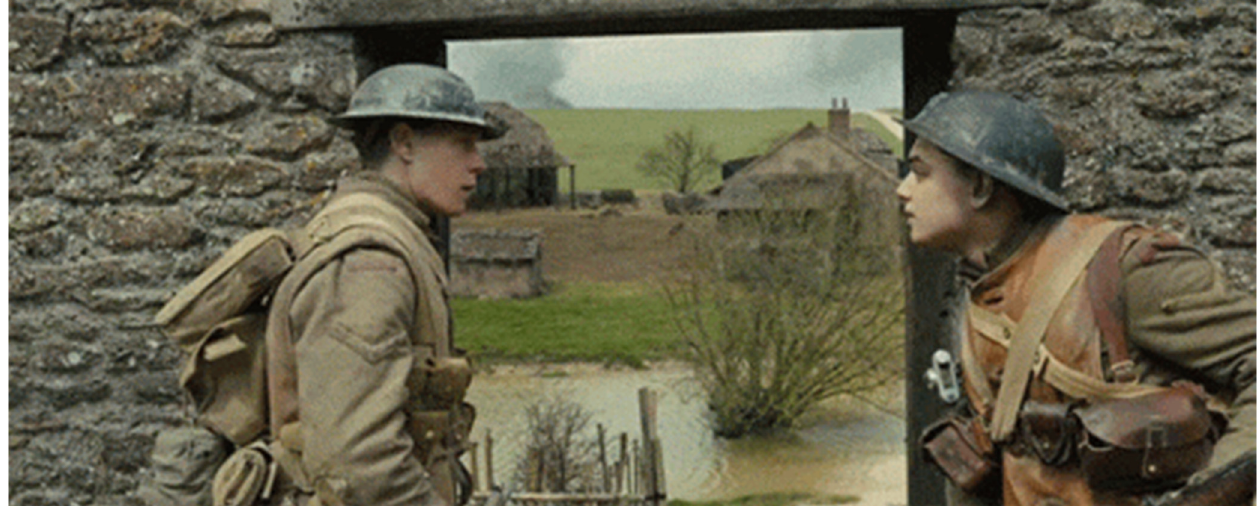
Figure 8. 1917 adapts the visual procedures of the third-person action-adventure game; for example, when characters are entering a space of uncertainty. (Screenshot created by author).